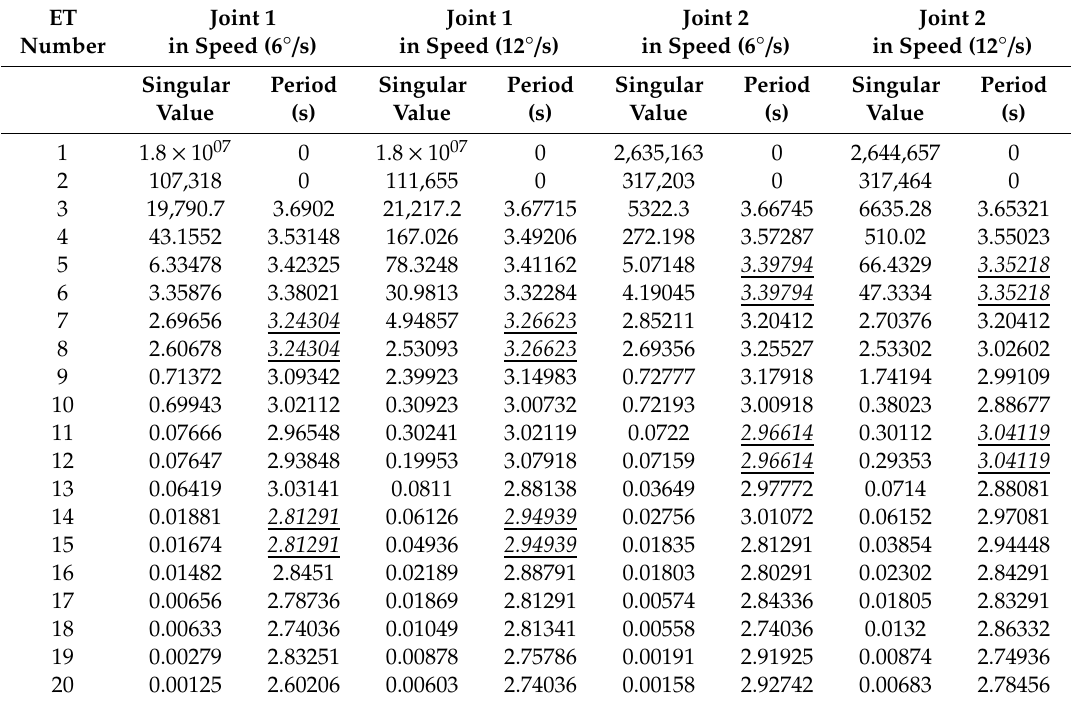
Table 4. The period and singular value of eigentriples for the position of the encoder signal (number 1–20).